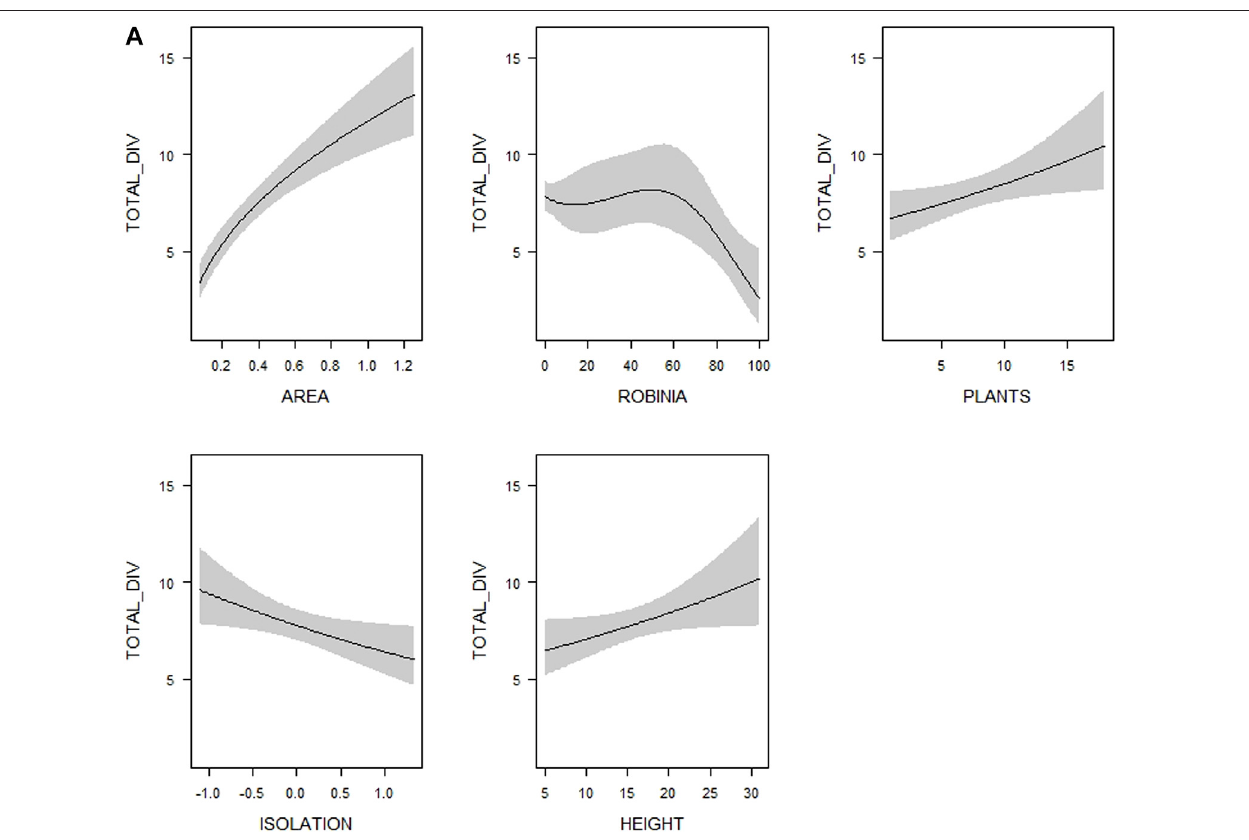
FIGURE 2 | Visualization of the relationships between (A) overall bird species richness (TOTAL_DIV – number of all bird species), (B) forest bird species richness (FOREST_DIV – number of forest bird species) and (C) farmland bird species richness (FARMLAND_DIV – number of farmland bird species), respectively, and woodlot characteristics (see Table 1 for their de fi nitions and abbreviations) included in the most supported generalized linear models (see Supplementary Table S4 ). Shaded areas correspond to 95% con fi dence intervals. The estimates from the best model for each response variable are shown.